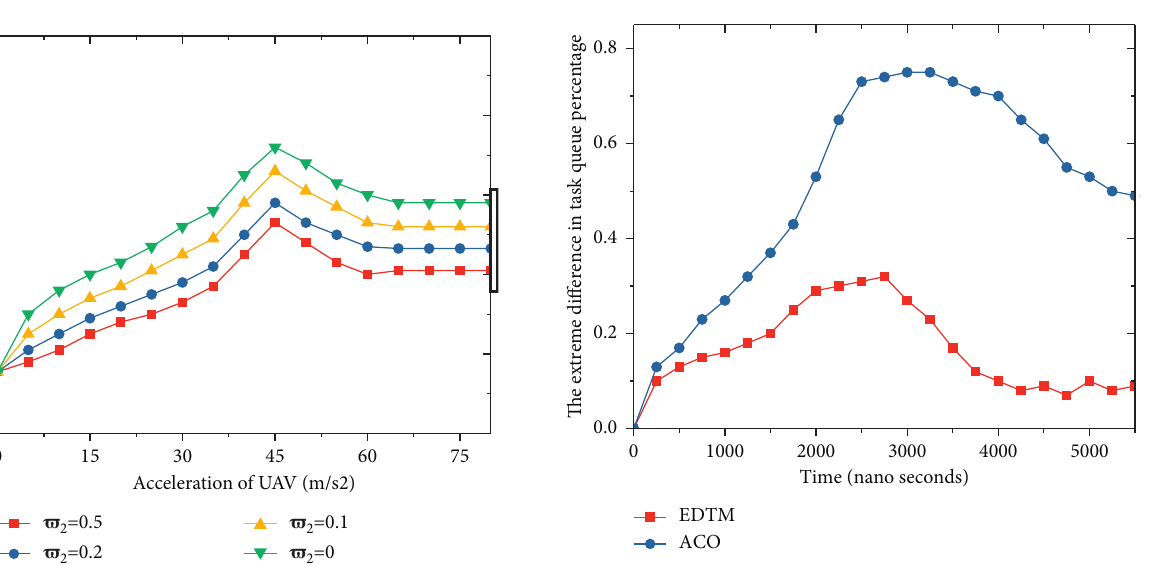
Figure 12: The comparison in optimizing UAVs load between the proposed EDTM algorithm and the algorithm ACO.